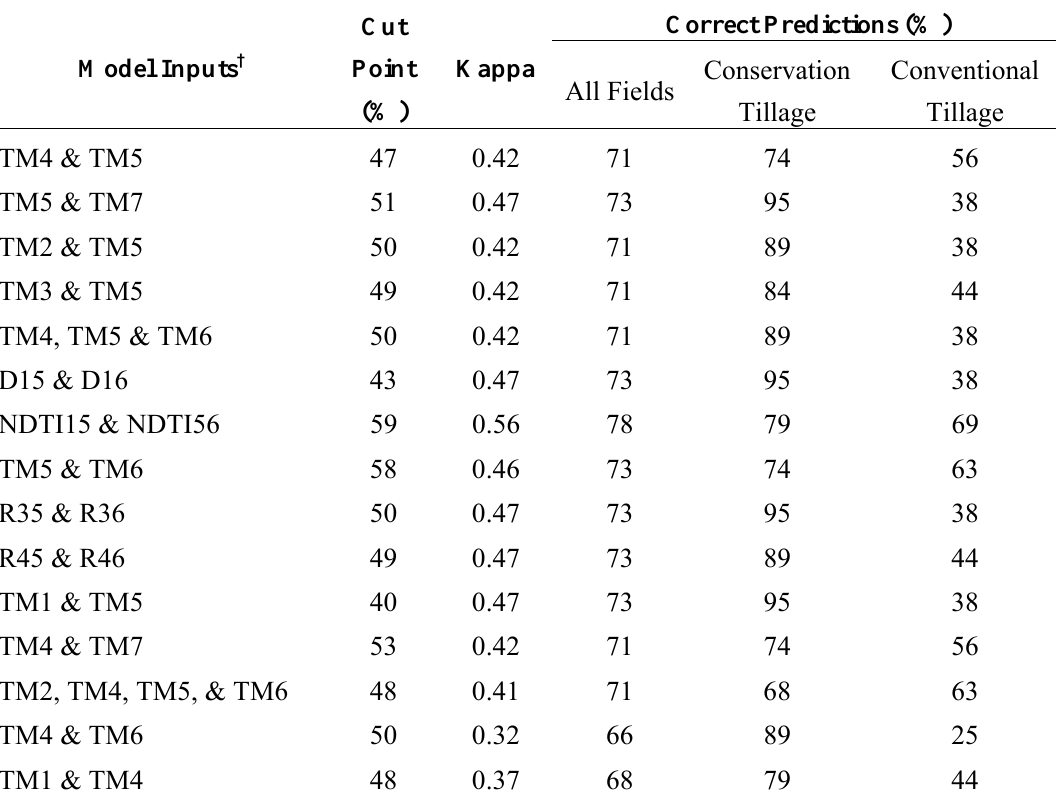
Table 4 . Validation performance of Landsat 5 TM based ANN models used for mapping tillage practices in Ochiltree County, Texas using Method-I (Cutoff probabilities values derived from the training data i.e. , Moore County